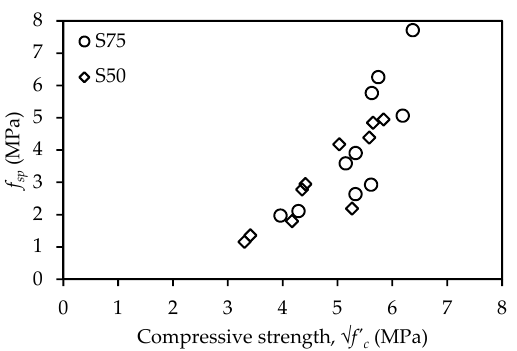
Figure 16. Relationship between splitting tensile and cylinder compressive strength.